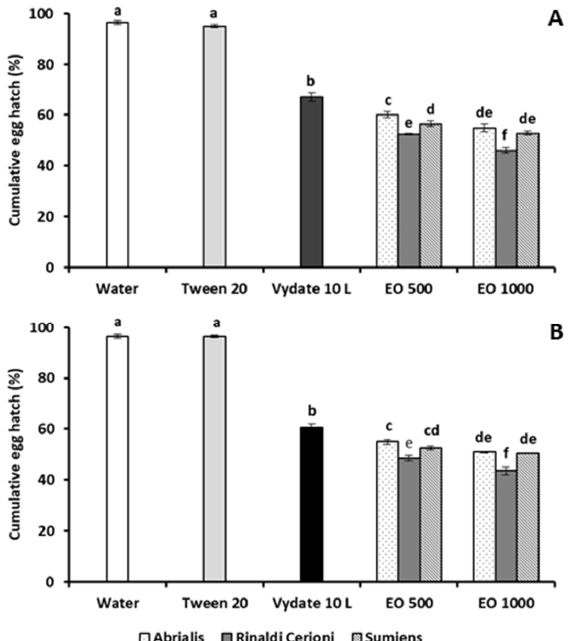
The hatchability of M. incognita eggs was always significantly reduced by treatments with the three lavandin EOs, without any statistical difference between the 24 and 48 h exposure (Figure 1).